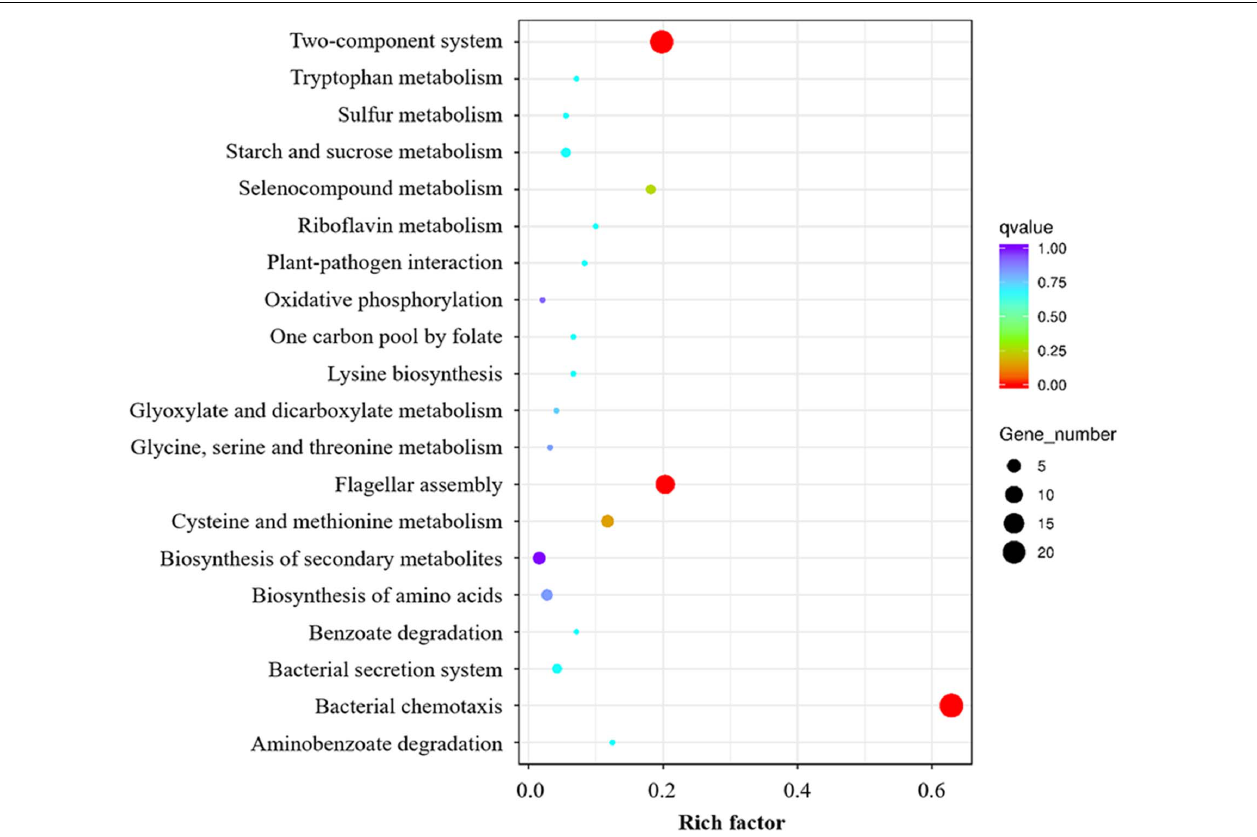
FIGURE 5 | KEGG enrichment analysis of overlapping pathways regulated by both RpoN1 and RpoN2. Different colors represent the enriched pathways, and the size of the circle represents the number of